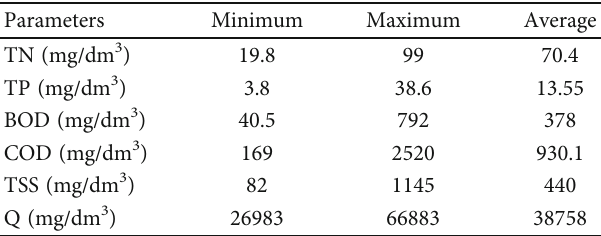
Table 5: Range of values of parameters describing in fl uent